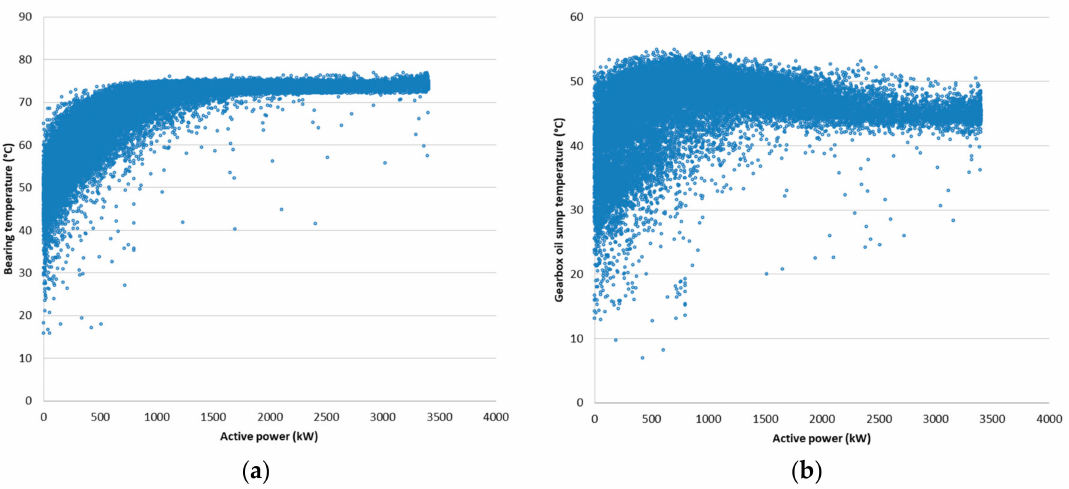
Figure 7. Gearbox temperature power functions during the first oil sampling interval of approx. six months. ( a ) Bearing temperature as a function of the active power (P act > 0); ( b ) gearbox oil sump temperature as a function of the active power (P act >